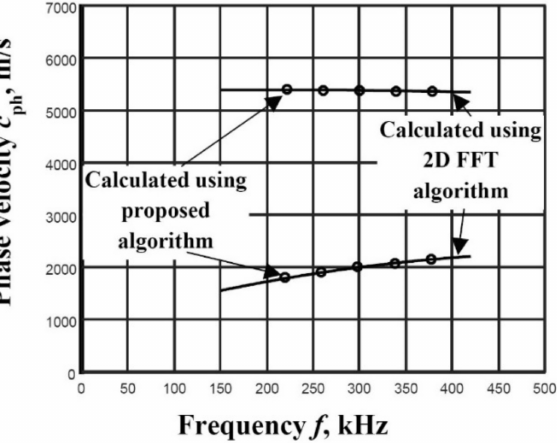
Figure 4. The reconstructed phase velocities of the A 0 and S 0 modes using the proposed algorithm (presented by circles) and by calculating peak values of spectrum magnitude from 2D-FFT (presented by solid line).